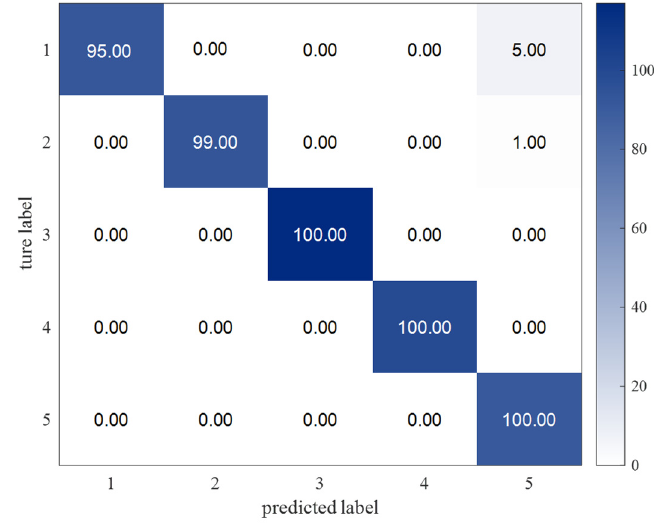
Figure 6. Confusion matrix of fault diagnosis.